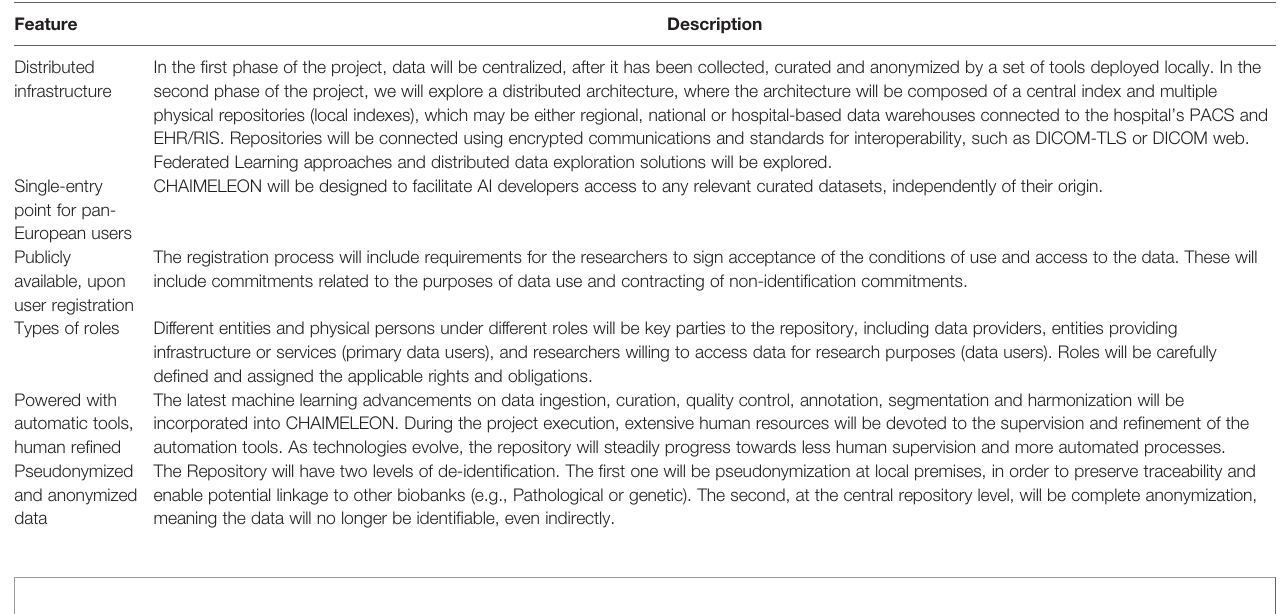
TABLE 2 | Summary of CHAIMELEON ’ s main design and infrastructure